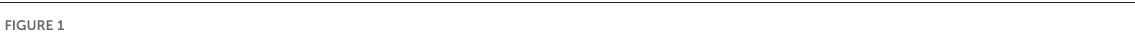
FIGURE1 (2%) only coated eggs were also included. Three eggs per treatment per sampling point (0, 1, 3, 5, 7, 14, 21 days) were included, and the experiment was replicated three times. Enrichment negative samples for SH were assigned a value of 0. Enrichment positive samples were assigned a value of 1.0 log CFU/egg. The differences between the means were compared at a significance level of 5%. Error bars represent SEM. Data tables below each graph indicate the mean differences in log counts between control and the respective treatment application and the associated p values for each time